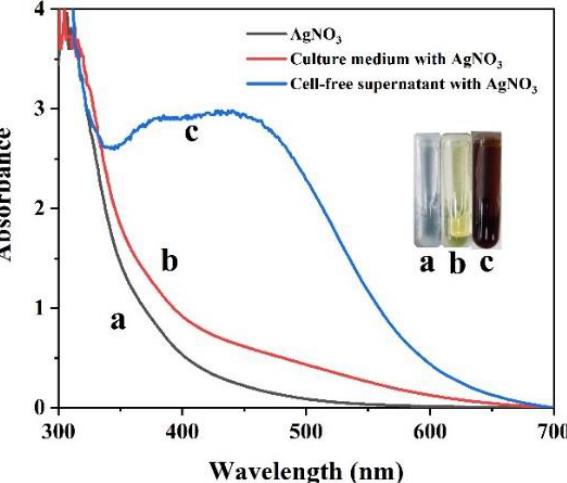
Figure 2. UV/vis spectral analysis of AgNO 3 ( a ), culture medium with AgNO 3 ( b ) and the culture supernatant of Shewanella sp. Arc9-LZ with AgNO 3 ( c ) over the wavelength range of 300–700 nm after 48 h of reaction .